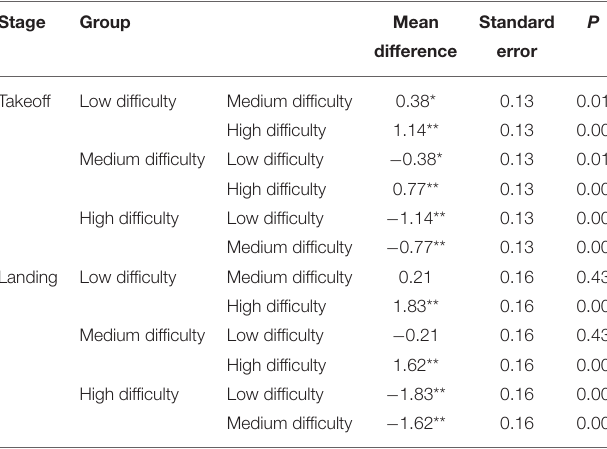
TABLE 8 | Variance analysis post-hoc comparison of children’s performance in tasks with different difficulty levels at different